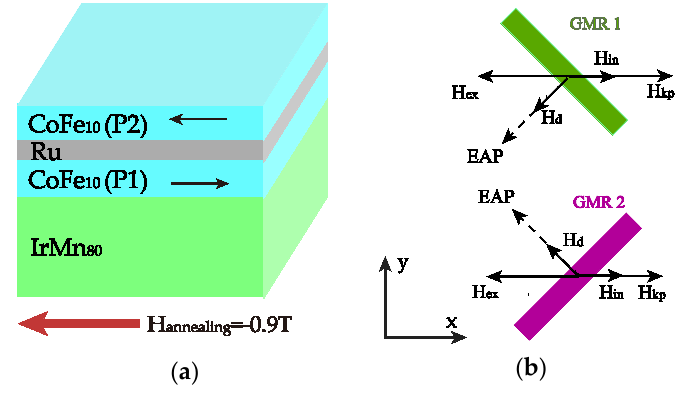
Figure 7. ( a ) Schematic of the exchange coupling field in SAF structure. ( b ) Direction of the pinned layer CoFe 10 (P2) easy axis (EAP) after annealing.